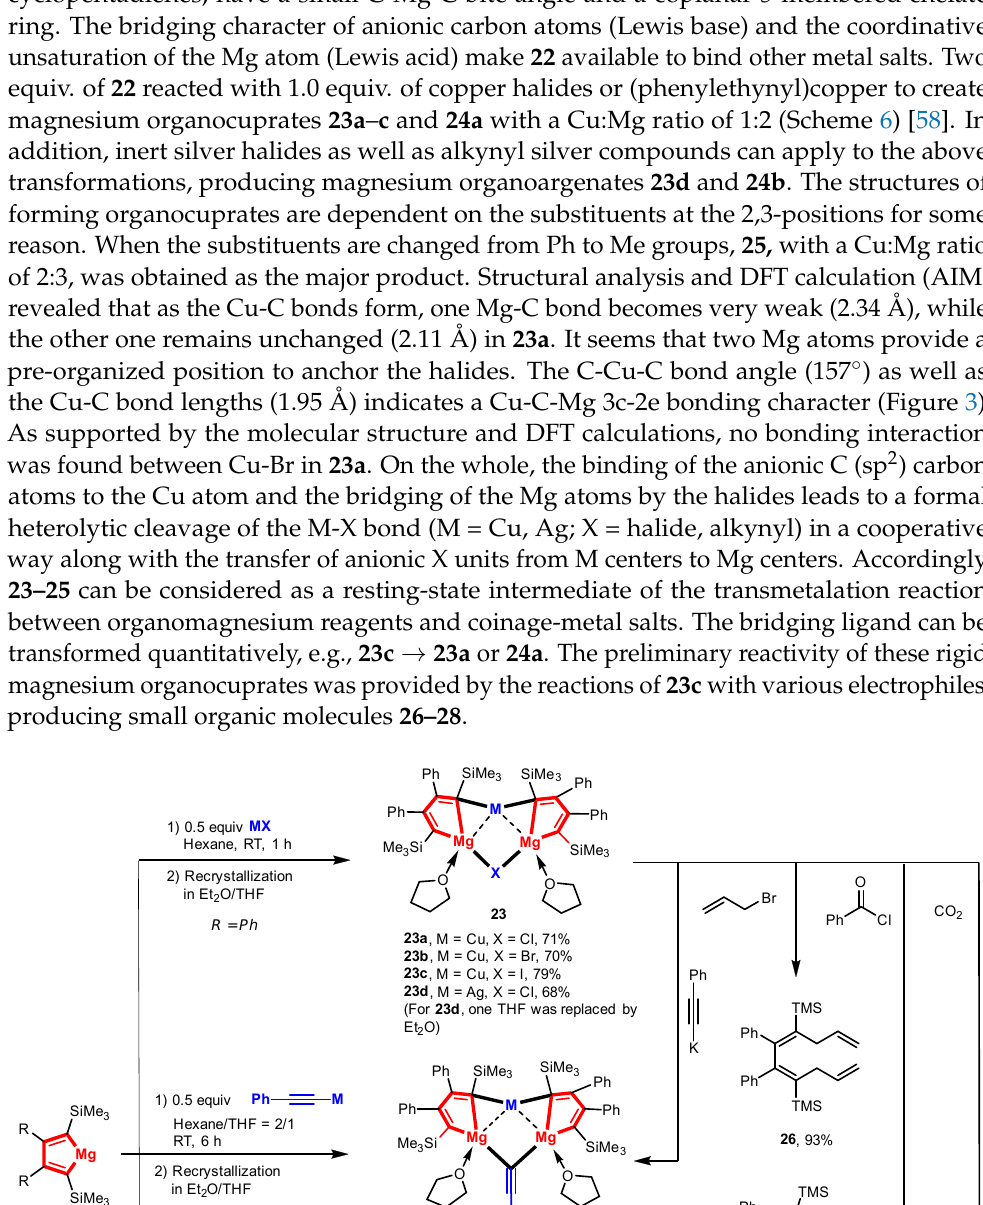
Figure 3. Molecular structure of 23b . Modified with permission from [58]. Copyright 2016 John Wiley and Sons. When a built-in coordinating site is added to the monoanionic phenyl skeleton at the ortho -position, it will generate a C,N-bidentate ligand, as shown in Scheme 7. With the (dimethylamino)methylphenyl (DMMP) lithium reagent 29 in hand, van Koten’s group developed two methods to synthesize the dicopper-dilithium organocuprate 30 : 1) a direct transmetalation of 29 with 0.5 equiv. of CuBr and 2) an interaggregate exchange reaction between DMMP copper cluster 31 (vide infra) and 29 [65,66]. The short averaged Cu-C bonds (1.94 Å) as well as the weak averaged Li-C bonds (2.39 Å) in 30 (Figure 4) suggest that the 2c-2e bond of the Cu-C bonds has a higher character [67]. However, the split cou- pling of 13 C- 7 Li (7 Hz) was still observed in solution, which indicates that the s electron density is present between the Li and C ( bridge ) nuclei [68]. Meanwhile, J ( 13 C- 7 Li) did not change during variable-temperature NMR studies, allowing it to exclude the intraaggre- gate exchange processes. By monitoring the characteristic signals of methylene protons (AB pattern) and N Me 2 protons (two singlets) using dynamic 1 H and 13 C NMR spectros- copies, van Koten and co-workers found the rotation of the 3c-2e bonded aryl groups